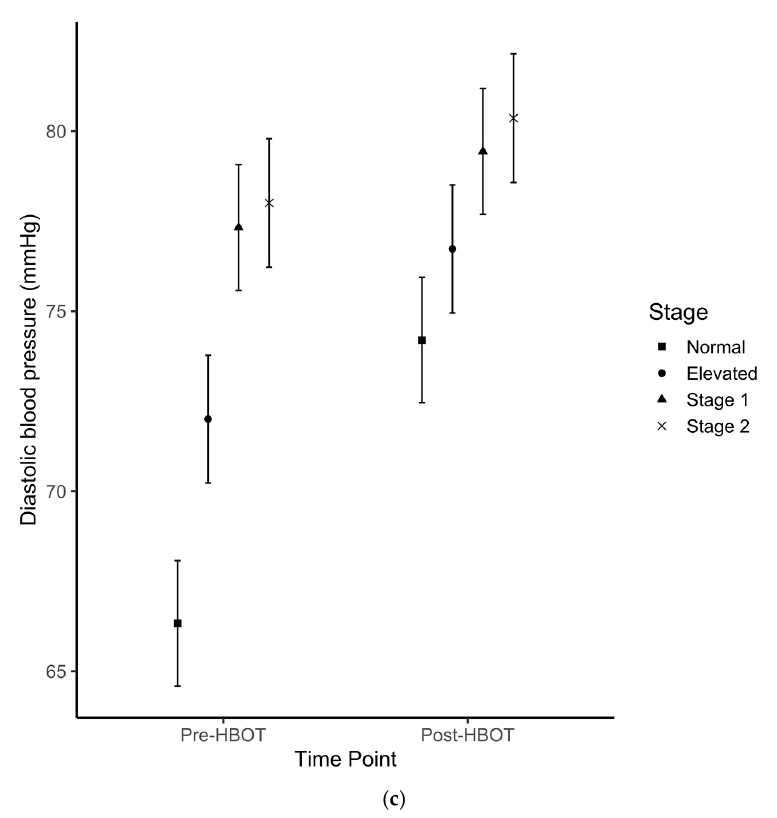
Figure 3. Estimated means ± SE for ( a ) mean-, ( b ) systolic- and ( c ) diastolic arterial pressures before and after hyperbaric oxygen treatment sessions across four categories of baseline arterial blood pressure measurements. Baseline arterial blood pressure classification: Normotensive; Elevated; Hypertension Stage 1; Hypertension Stage 2. Table 6. Contrasts between changes in arterial blood pressure before and after HBOT, across different baseline blood pressure categories.